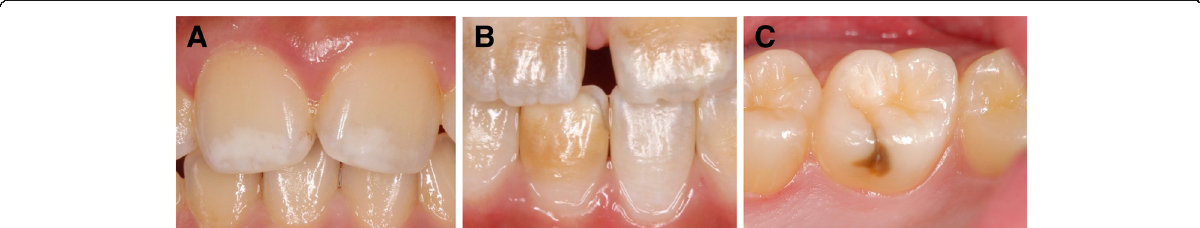
Fig. 1 Tooth discoloration in a child with MIH was graded according to the color shade as follows: a white opacity, b yellow/brown opacity, and c dark brown opacity